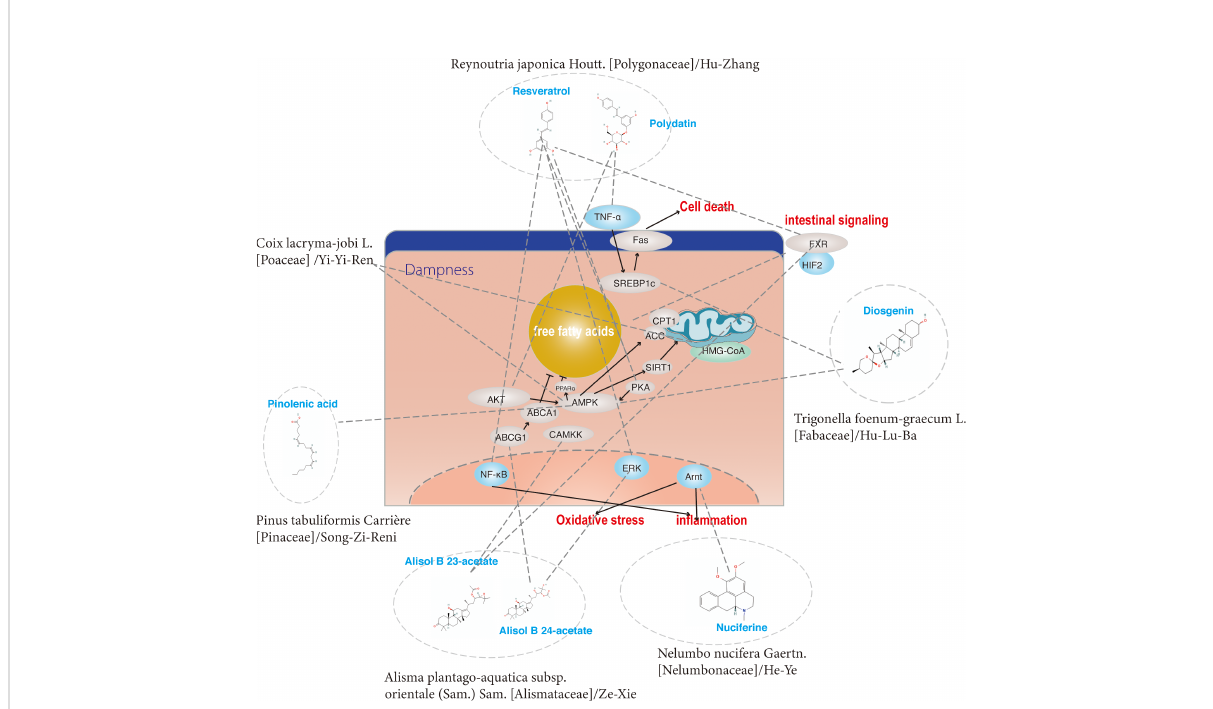
FIGURE 4 The regulatory effects on pathways induced by a group of ingredients from dispelling dampness (Qu Shi) and dissolving turbidity (Hua Zhuo)